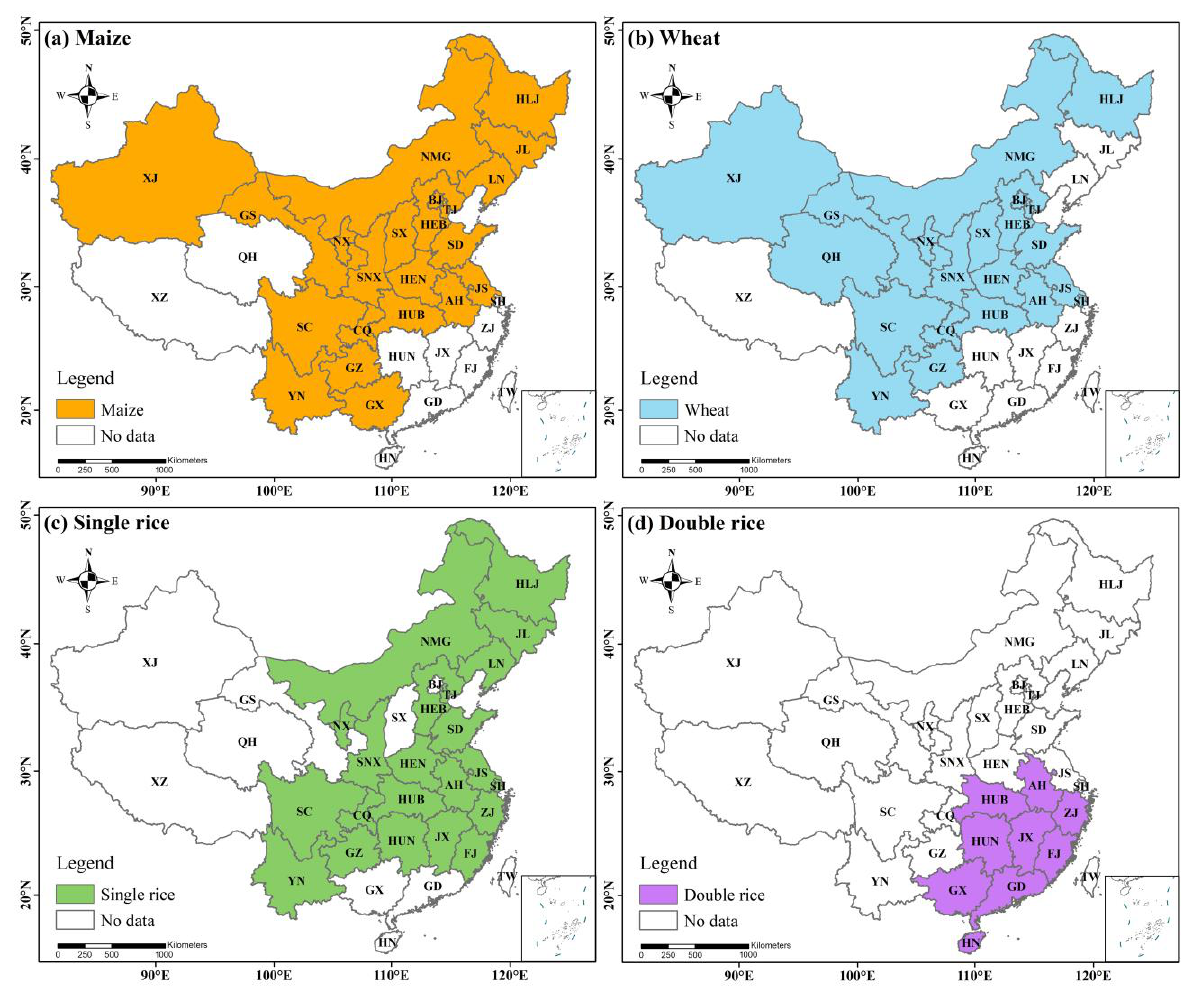
Figure 1. The distribution of field for ( a ) maize, ( b ) wheat, ( c ) single rice and ( d ) double rice systems from 2004 to 2018 in China. The four coloured regions represent different cultivated zones for ( a ) maize, ( b ) wheat, ( c ) single rice and ( d ) double rice.